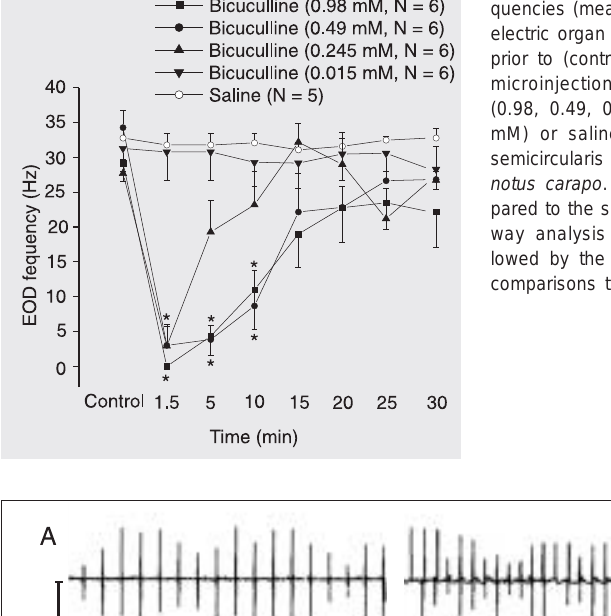
Figure 2. Time course of the fre- quencies (mean ± SEM) of the electric organ discharge (EOD) prior to (control) and following microinjections of bicuculline (0.98, 0.49, 0.245, and 0.015 mM) or saline into the torus semicircularis dorsalis of Gym- notus carapo . *P < 0.05 com-